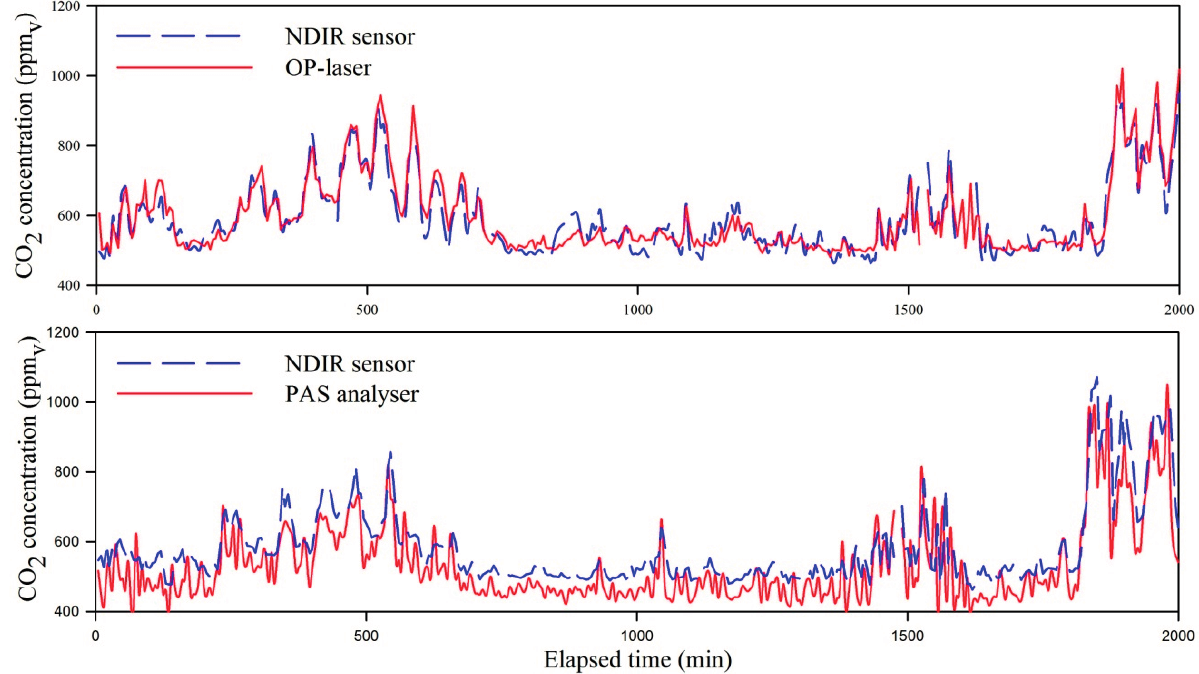
Figure 7. Snapshot of CO 2 concentrations in the dairy cow barn monitored with NDIR sensors, when compared with the OP-laser while used to measure the mean concentration in an open-path of 64 m in the cow barn with five sensors and the ( top ) and compared with the PAS analyzer on a single-point basis ( bottom ). The top and bottom plots are from data collected in a simultaneous